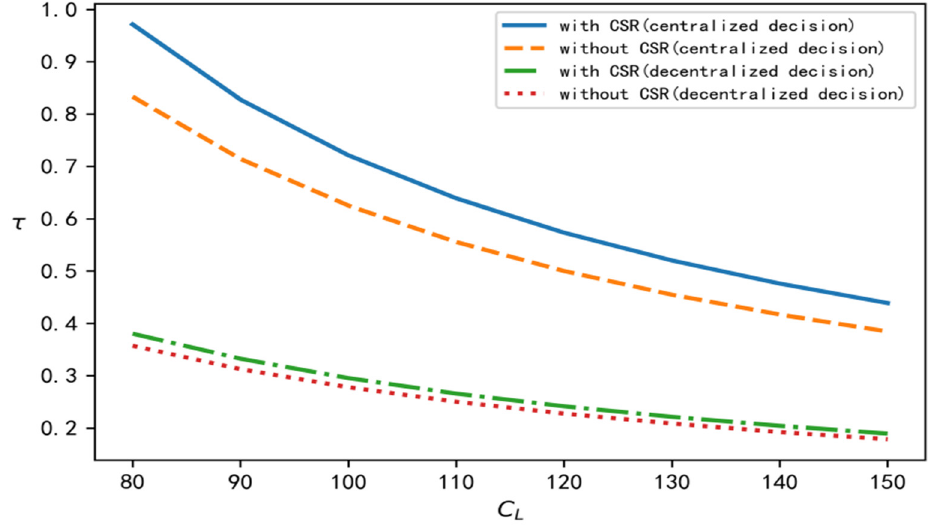
Figure 1. Change trend of product recovery rate.